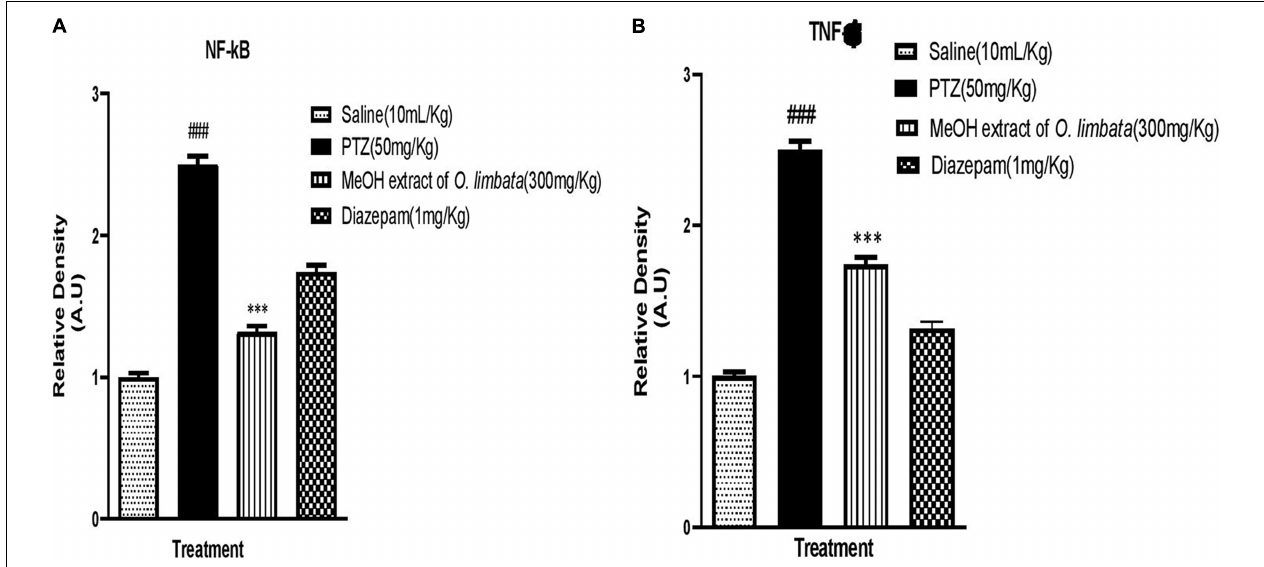
FIGURE 9 | (A) Inhibitory effect of O. limbata against phosphorylated nuclear factor kappa B cells (p-NFkB) in PTZ-induced mice brain tissues, using western blotting. One-way ANOVA with post hoc Tukey’s test. Values expressed as mean ± SEM ( n = 3). ### P < 0.0001 vs. saline group; *** P < 0.0001 vs. PTZ group.